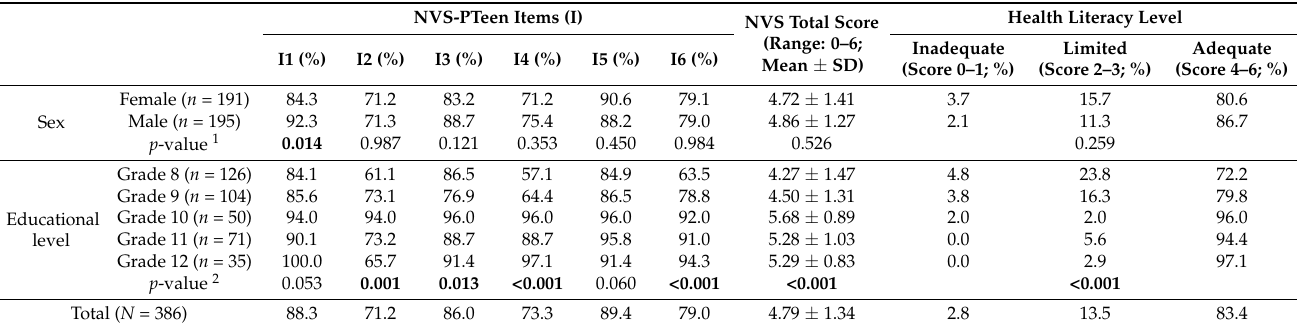
Table 2. The Newest Vital Sign for the Portuguese adolescents’ population (NVS-PTeen) score comparison for (a) sex and (b) educational